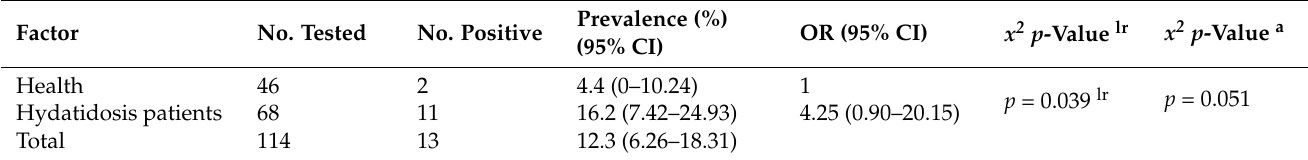
Table 2. Prevalence and factors associated with Blastocystis infection in hydatidosis patients and healthy people in Qinghai, China.